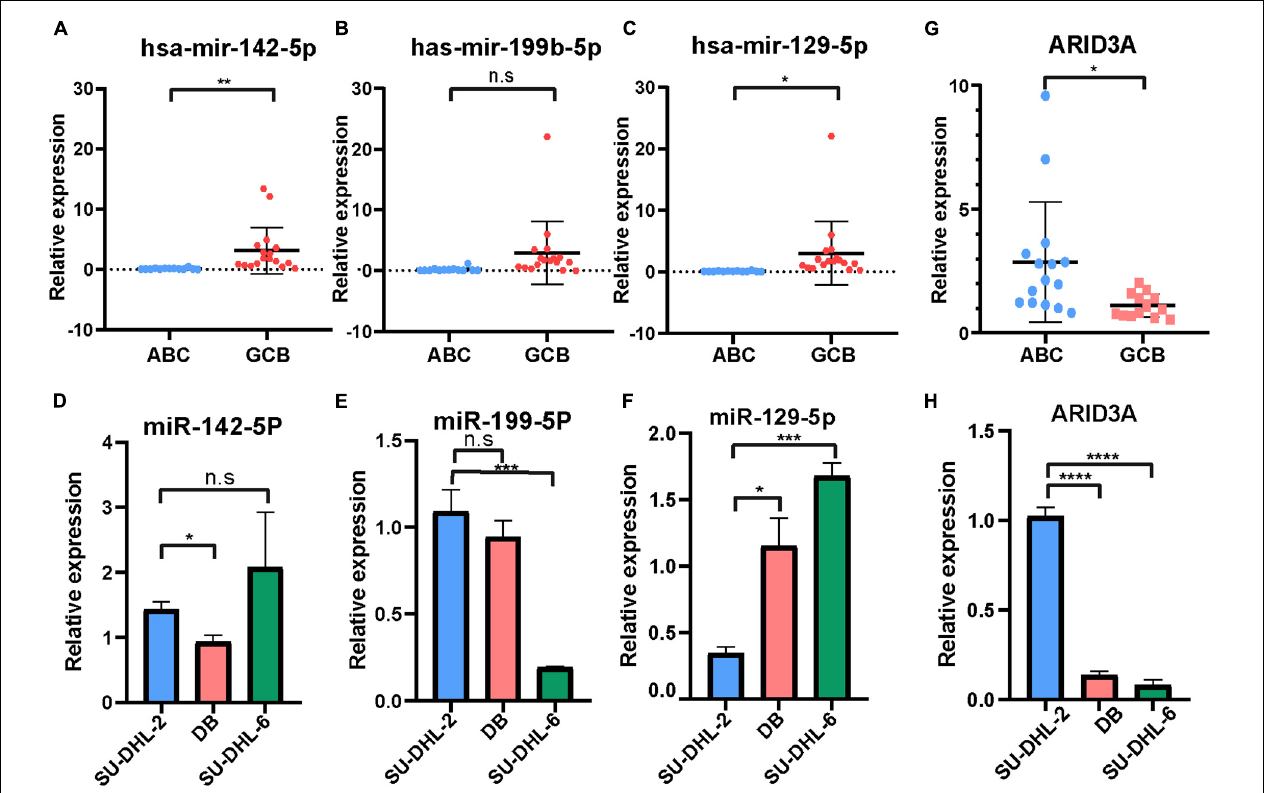
FIGURE 2 | (A–C) RT-qPCR showing the expression of hsa-miR-142-5p, hsa-miR-199b-5p, and hsa-miR-129-5p in the ABC and GCB subtypes DLBCL patients. (D–F) RT-qPCR showing the expression of hsa-miR-142-5p, hsa-miR-199b-5p, and hsa-miR-129-5p in the SU-DHL-2 (ABC subtype) and DB and SU-DHL-6 (GCB subtype) cell lines. (G,H) QRT-PCR showing the expression of ARID3A in the ABC and GCB subtypes DLBCL patients and cell lines, respectively. All data represented mean ± SD from three independent experiments. NS: P > 0.05; * P < 0.05; ** P < 0.01; *** P < 0.001; **** P < 0.0001.